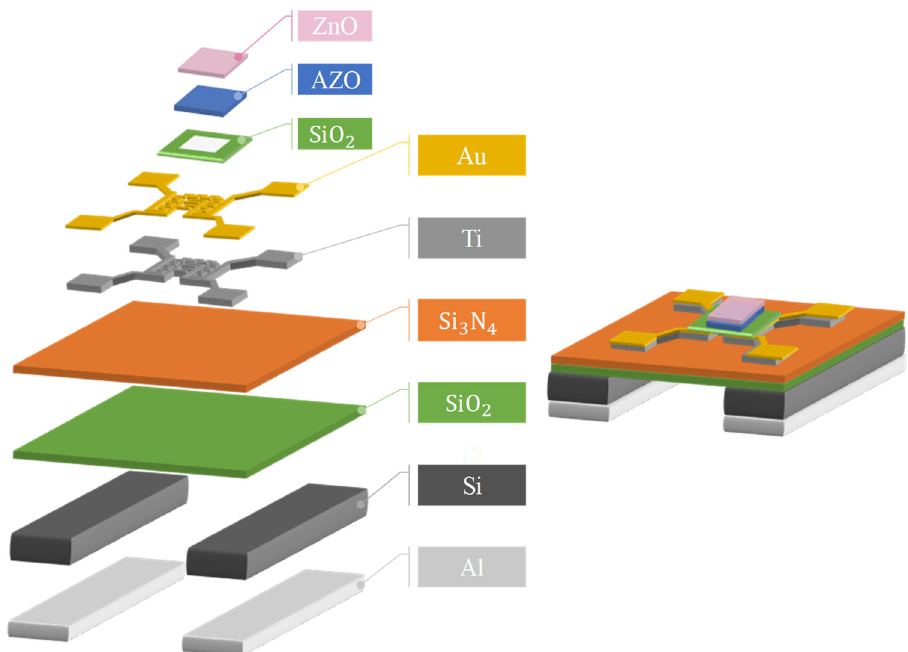
Figure 2. Three-dimensional figure of the fabricated MEMS microheater.